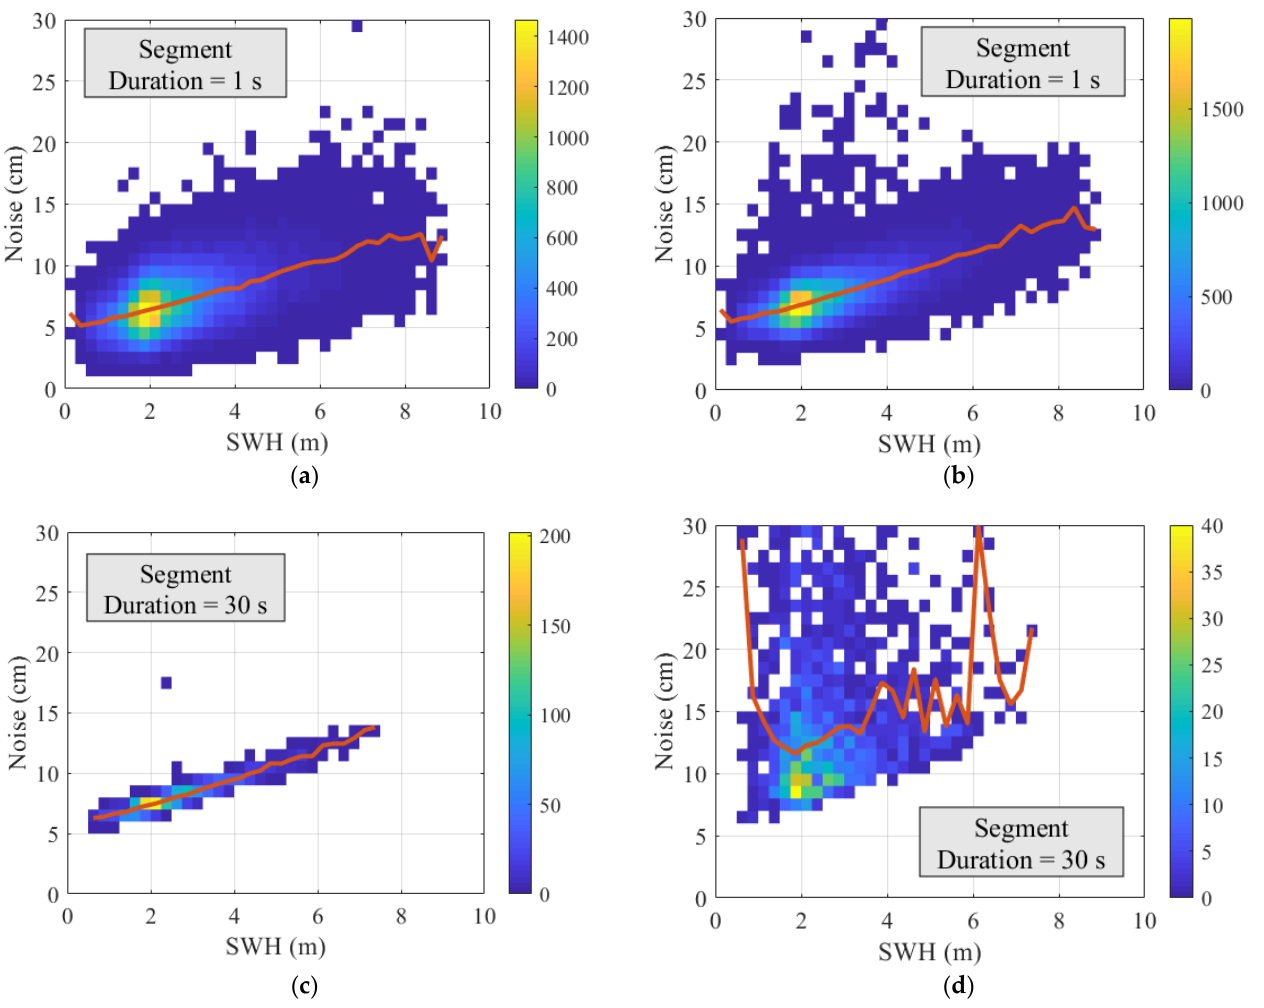
Figure 5. The two-dimensional statistical histograms of the estimated NL and SWH for differential method ( a , c ) and nondifferential method ( b , d ) when the segment durations were 1 s ( a , b ) and 30 s ( c , d ). The red curves represent the statistical medians.